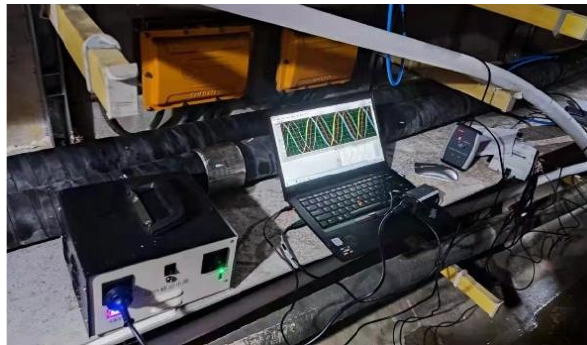
Figure 8. Measurement of harmonic data.